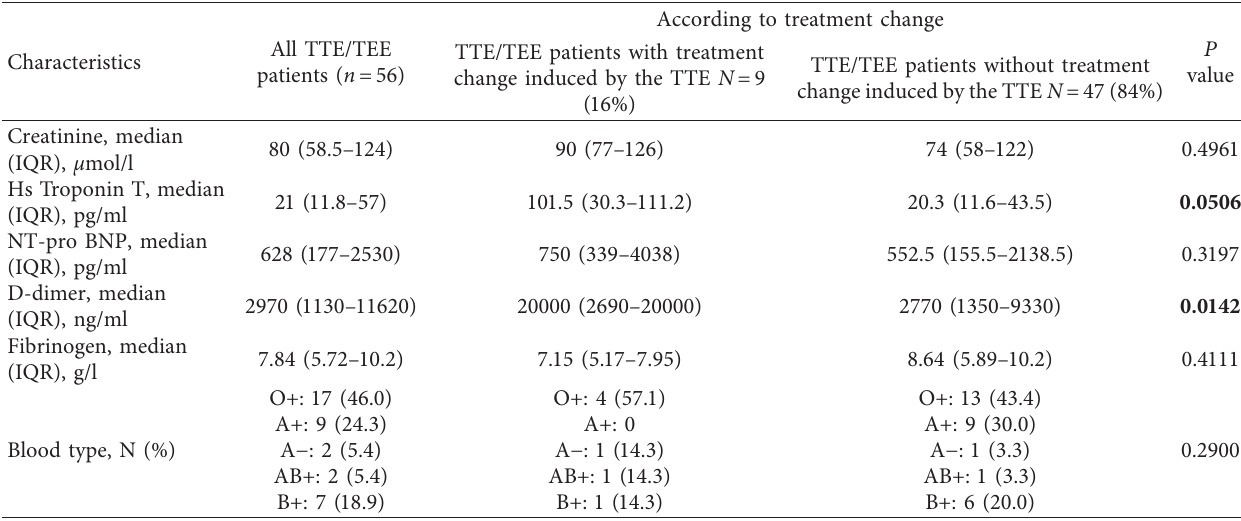
Table 3: Biological characteristics of the patients